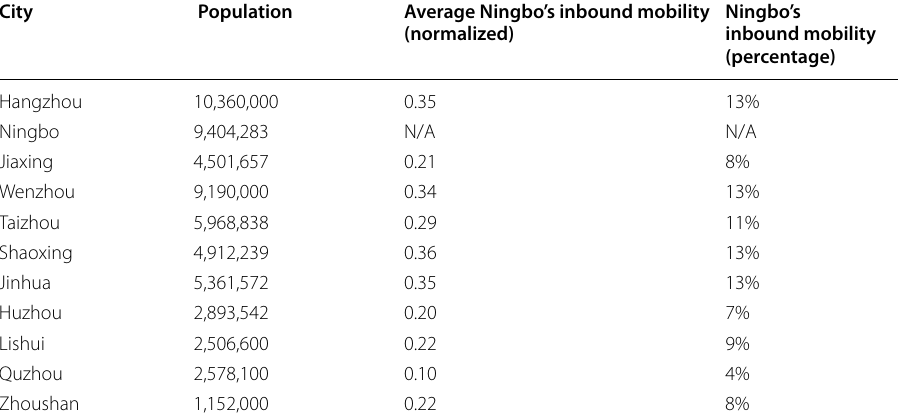
Table 1 Average population and Ningbo’s inbound mobility for Zhejiang cities from January to